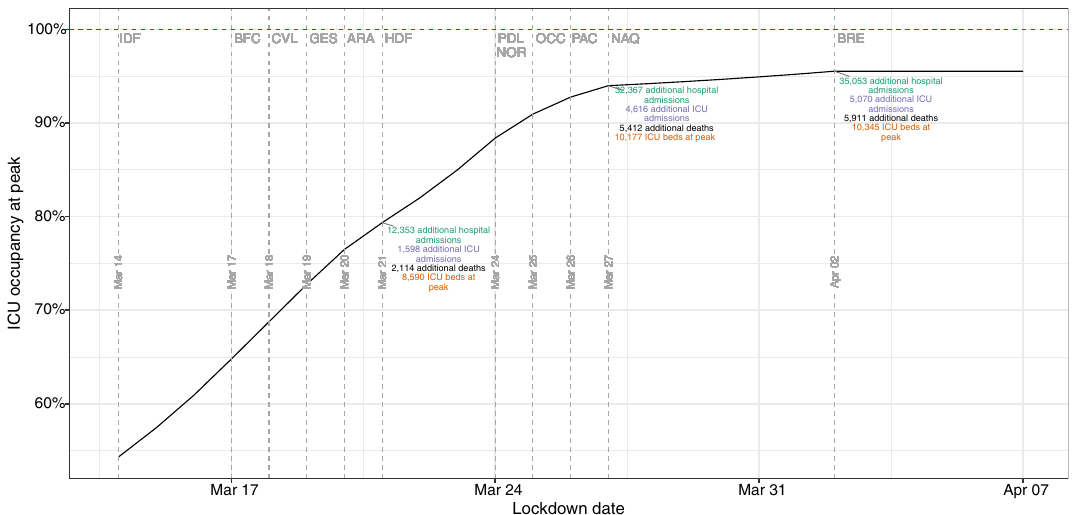
Figure 3. ICU beds occupancy in case of regional lockdowns to avoid regional ICU saturation. Vertical dashed lines indicate the moment when regions have to be locked down to avoid a saturation of their ICU capacity. Three regions (GES, IDF, BFC) would be locked from the start of the study period. One region (BRE) could have been locked on April 2, 2020, all others would have been locked before March 27, 2020. ICU intensive care unit, GES Grand-Est, IDF Ile-de-France, BFC Bourgogne-Franche-Comté, ARA Auvergne-Rhône-Alpes, CVL Centre-Val de Loire, HDF Hauts de France, PAC Provence-Alpes-Côte d’Azur, PDL Pays de la Loire, NOR Normandie, OCC Occitanie, NAQ Nouvelle-Aquitaine, BRE Bretagne. For example, delaying the national lockdown 2 weeks later on March 31 would have led to 1334 additional deaths with R prelockdown = 1.1 but 5913 additional deaths with R prelockdown = 1.5 (Fig. 4). In addition, for any given reproduction number, the cost of delaying the lockdown increases with time, for all outcomes. As an example, a synchronized lockdown on March 10 with a reproduction number equal to 1.5 would have led to 2105 fewer deaths, whereas on March 24 it would have led to 2653 additional deaths (other hospital-related outcomes are presented in supplementary material).